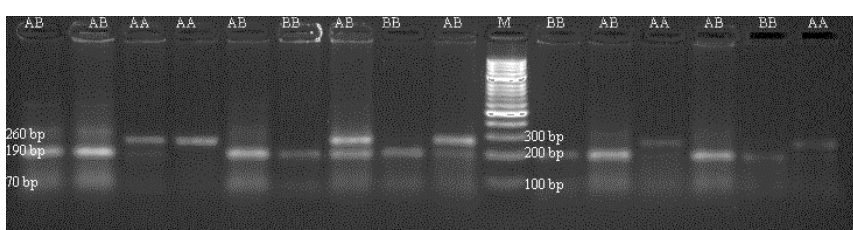
Figure 3. PCR-RFLP gel image of Pit-1 / Hinf I polymorphism. AA: 260bp, AB: 160/190/70bp, BB: 190/70bp.